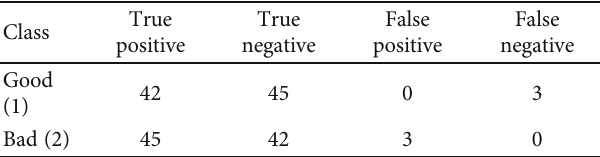
Figure 2: Fuzzy membership functions in FWRVM for two bread input. Table 3: Confusion matrix of